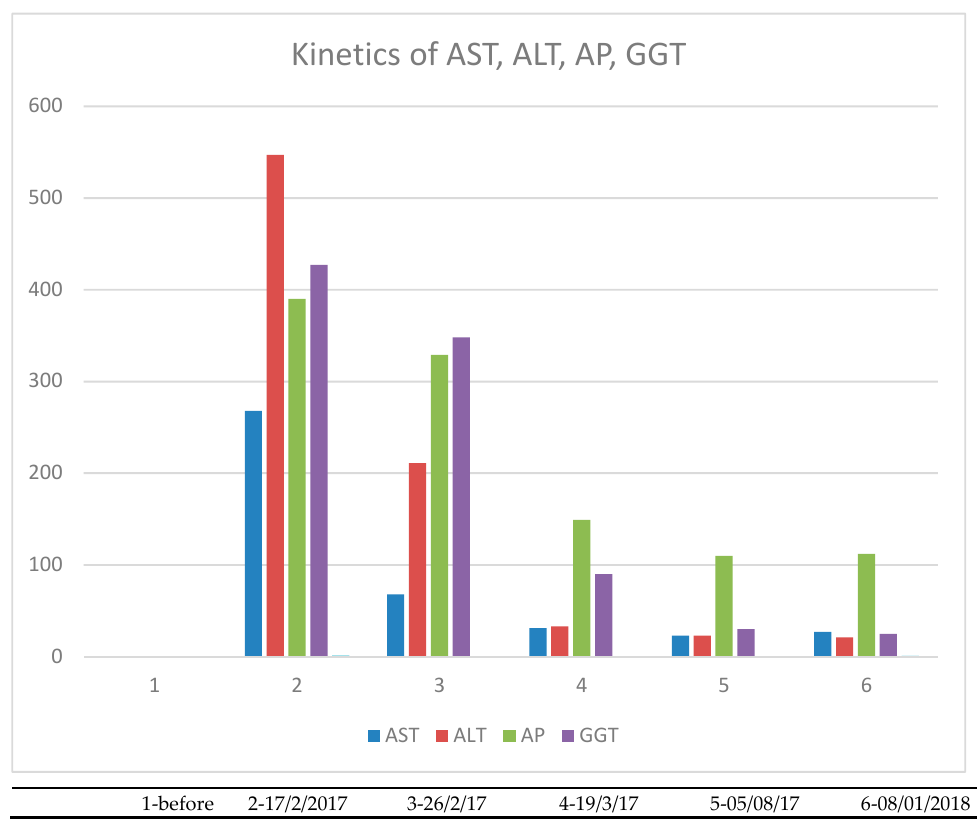
Figure 1. Kinetics of liver enzymes during the hospitalization and observation.